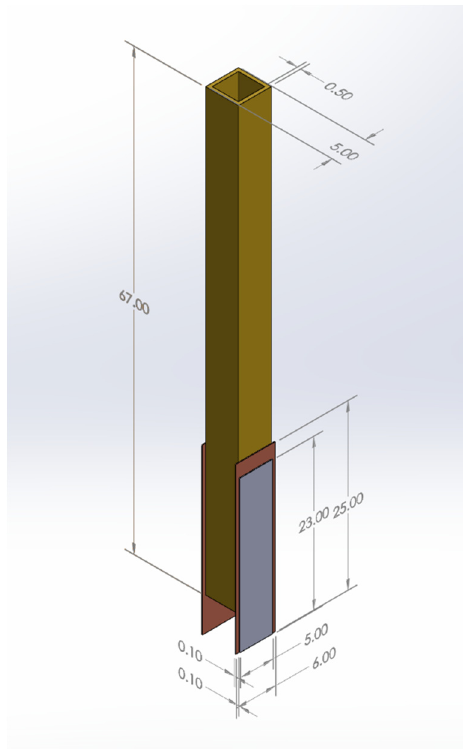
Figure 2. Final prototype dimensions in mm.